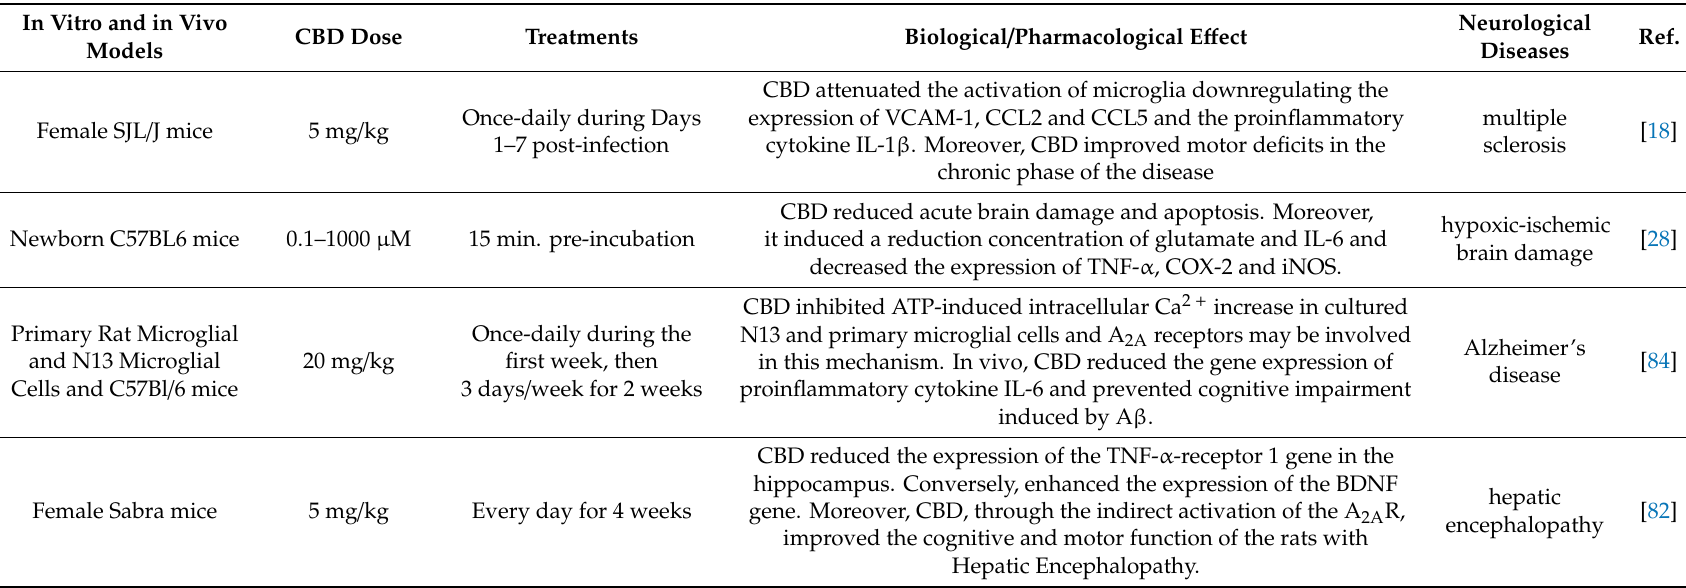
Table 1. Neuroprotective e ff ects of CBD in di ff erent neurological diseases through the activation of the A 2A